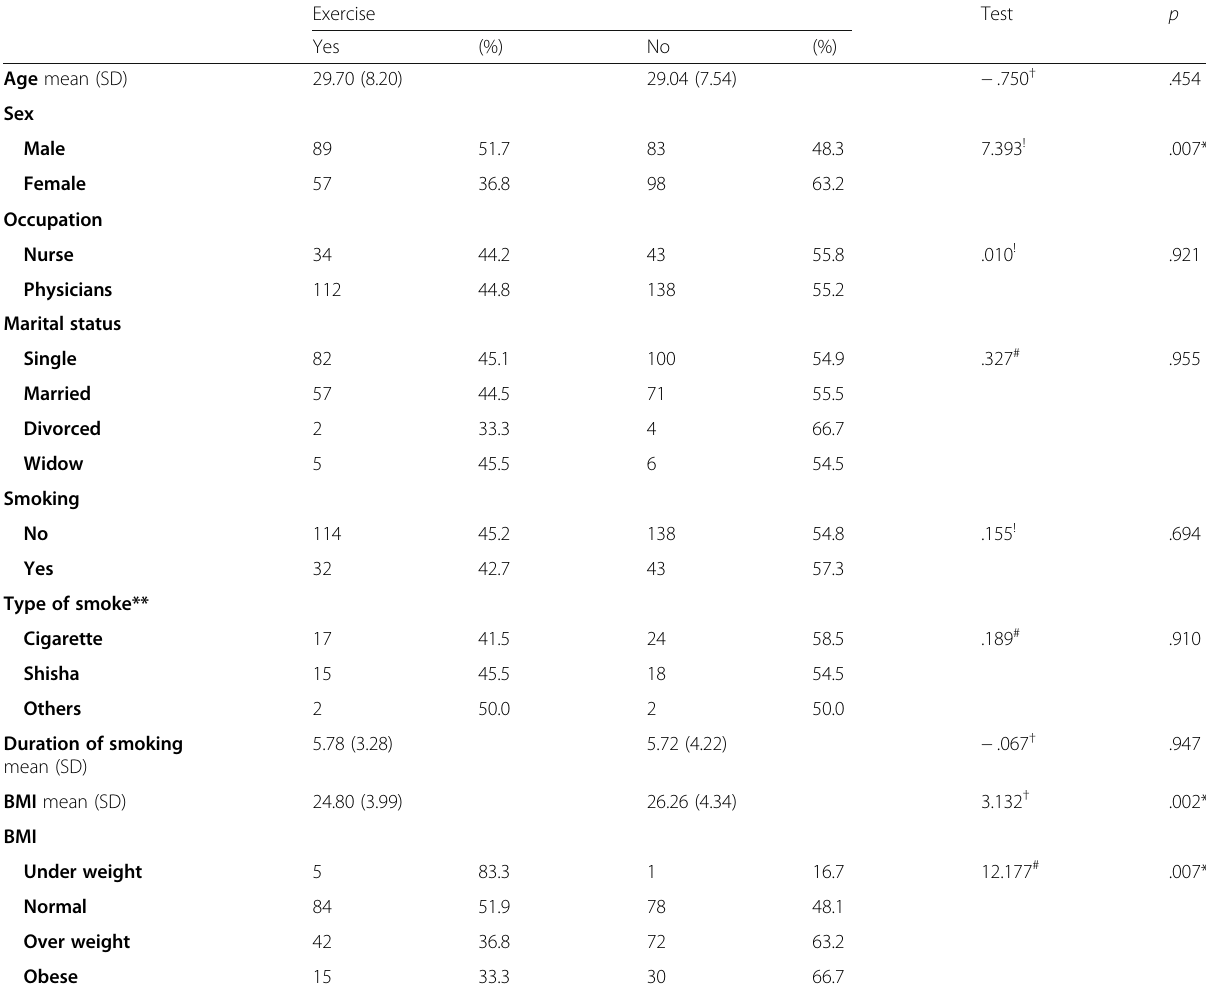
Table 2 Association between participants ’ characteristics and physical exercise Exercise